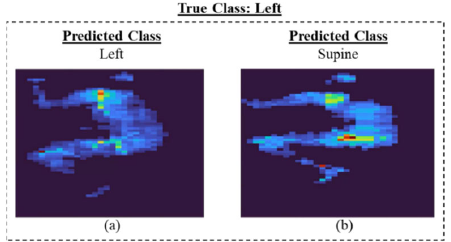
Figure 3. Sample video frames of I3D model for ( a ) correct and ( b )incorrect classification.